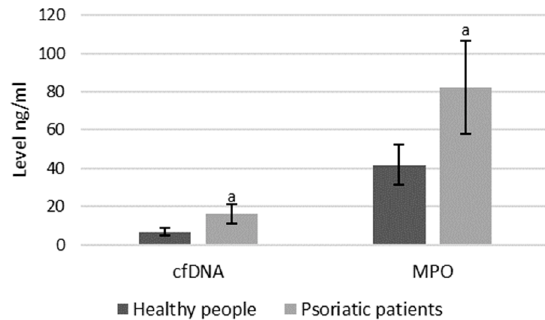
Figure 8. Plasma MPO and cfDNA levels in healthy subjects ( n = 14) and patients with psoriasis ( n = 28). a—statistically significant difference between neutrophils from patients with psoriasis vulgaris and healthy subjects; p < 0.05.